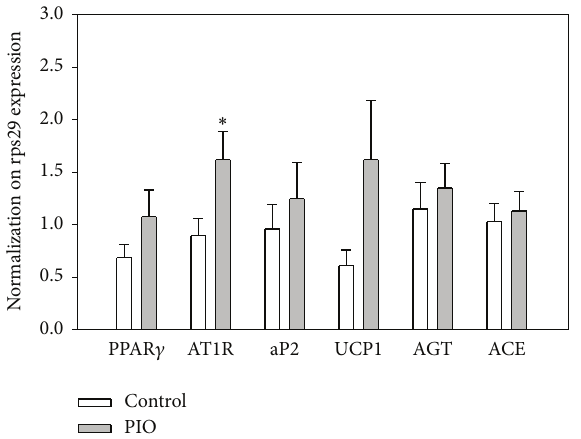
Figure 3: Effect of pioglitazone administration on expression of several genes in epididymal fat (adipose) tissue of young SHRs. Expression was normalized to the expression of rsp29.